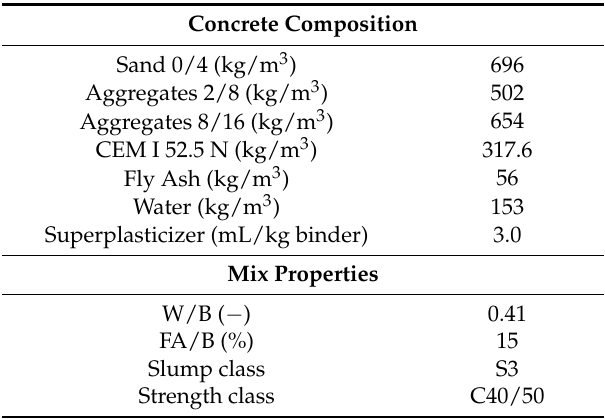
Table 1. Mix proportions and properties of the concrete